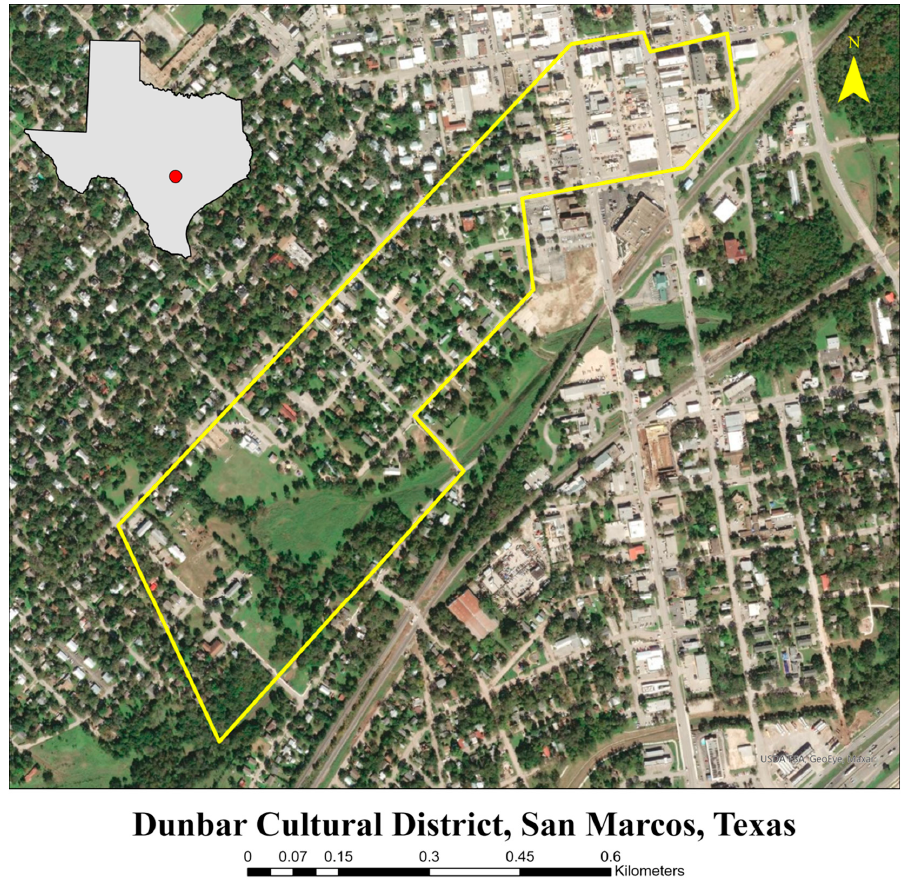
Figure A1. Dunbar Cultural District, San Marcos, Texas. Dunbar Cultural District in San Marcos, Texas, USA. Data for this map were obtained from the City of San Marcos, Texas department of Transportation, and Esri